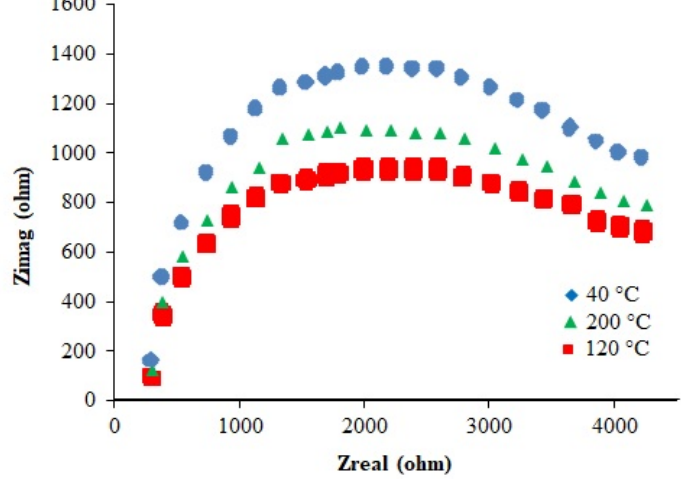
Figure 10. Impedance spectra of the iron complex recorded at 40, 120 and 200 °C. Table 2. Resistance and conductivity data of the iron complex at different temperatures.